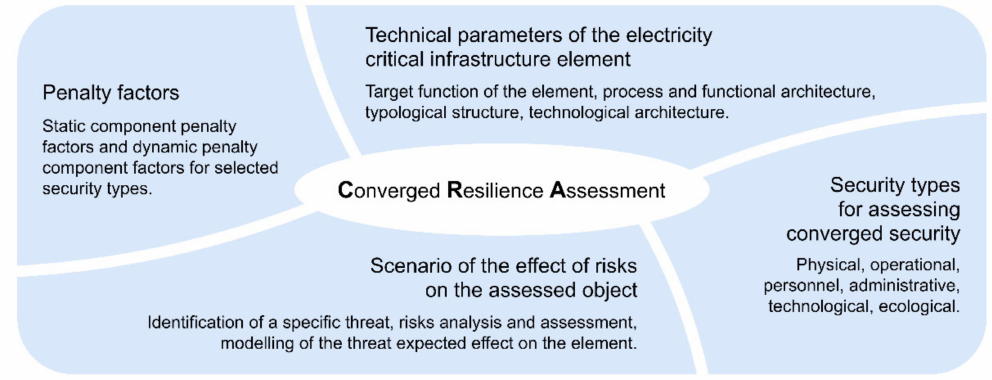
Figure 2. Converged Resilience Assessment